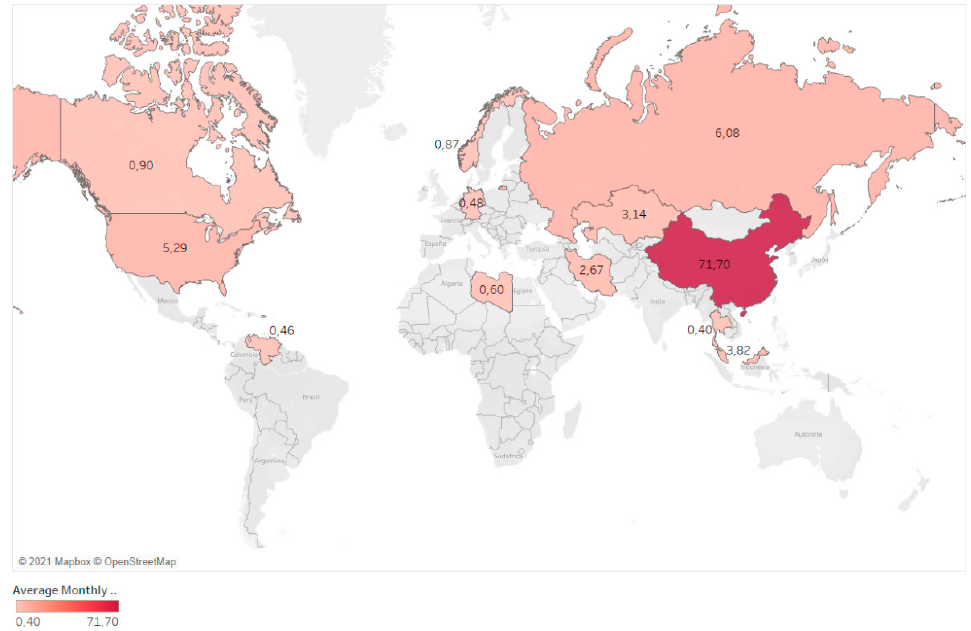
Figure 3. Breakdown of average monthly hash rate by country. Source: Own elaboration using Tableau Desktop Professional Edition and data extracted from University of Cambridge: Cambridge Bitcoin electricity consumption index. Data from May 2021.